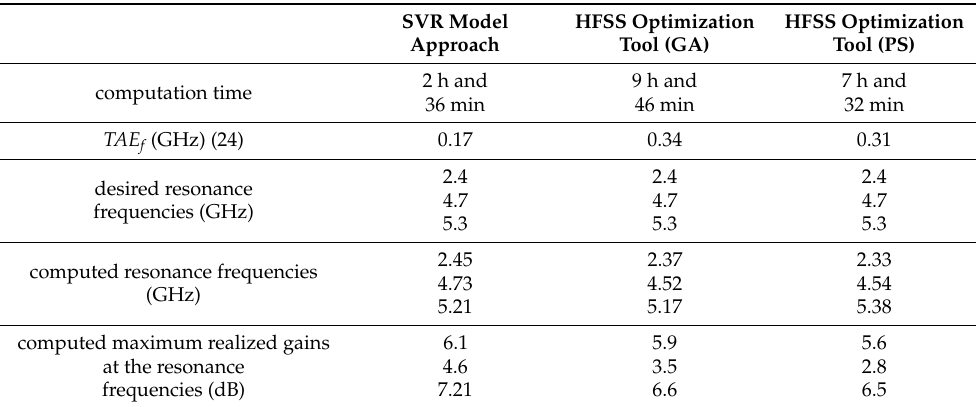
Table 5. Comparison of results of SVR model and HFSS optimization tool.